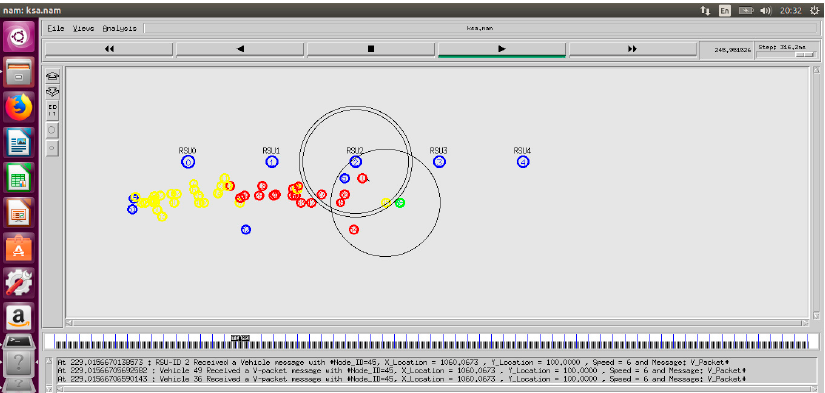
Figure 9. Simulation of the TARS protocol.